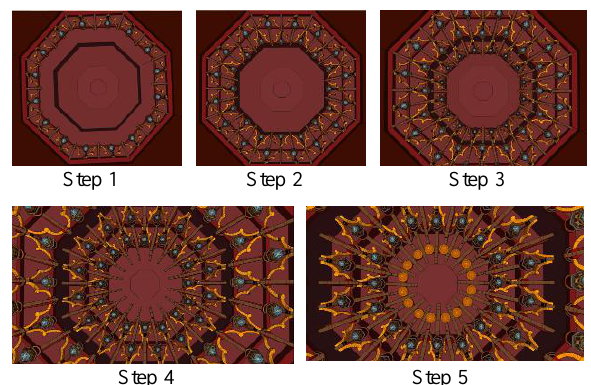
Figure 14. Construction procedure simulation. construction: from outer to inner parts and from bottom to